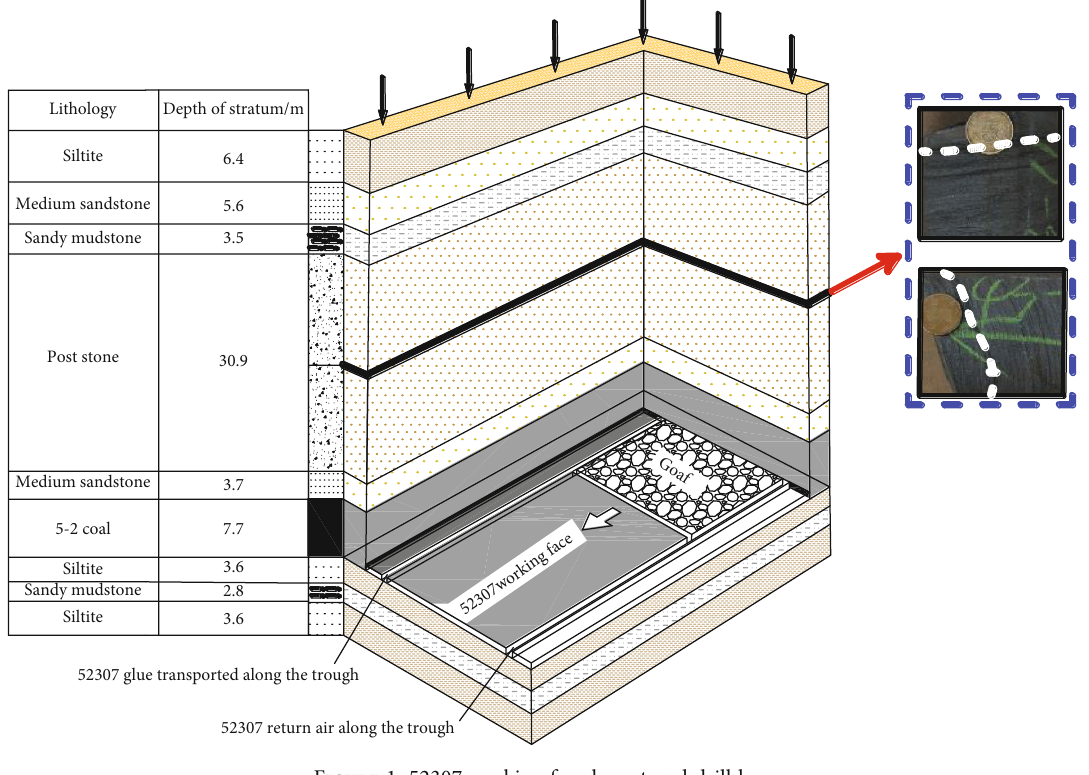
Figure 1: 52307 working face layout and drill log.